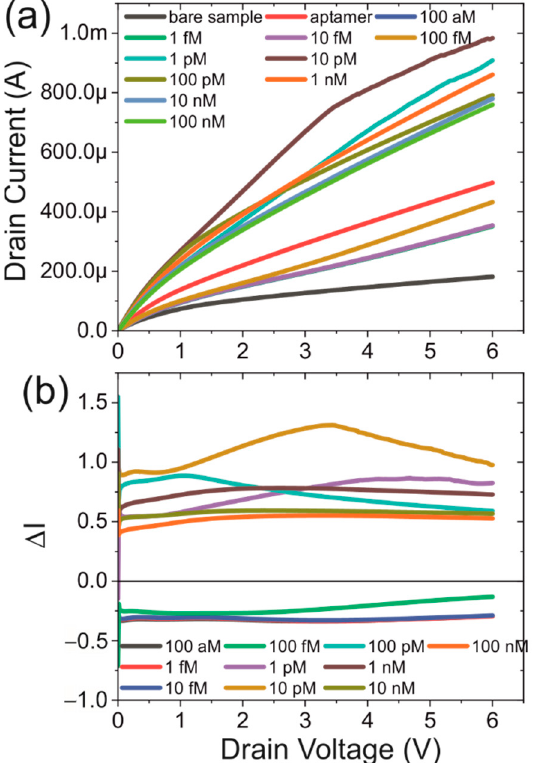
Figure 5. ( a ) IV-characteristics of a functionalised device with at varying spike protein concentrations (up sweep only). ( b ) The relative change of the current as a function of bias potential.